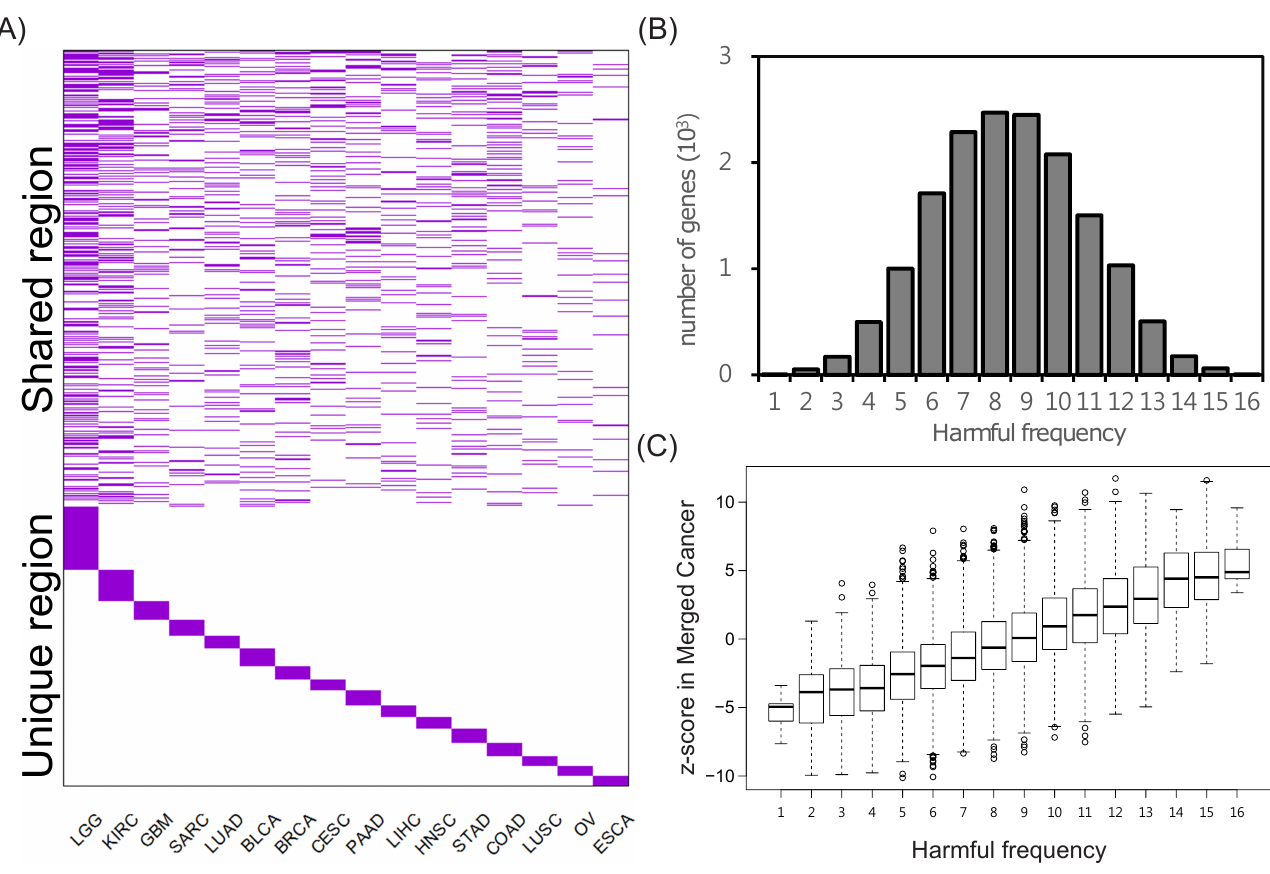
Figure 2. Exclusiveness and generality of SIGs. ( A ) Presence matrix of the survival influential genes across cancers. Each column indicates cancer type and each row the union of both harmful genes and protective genes of 16 cancer types. ( B ) The distribution frequency in which the genes were identified as harmful across cancers. ( C ) The association between the z-score of genes in the merged cancer data set and the frequency with which the genes were identified as harmful across